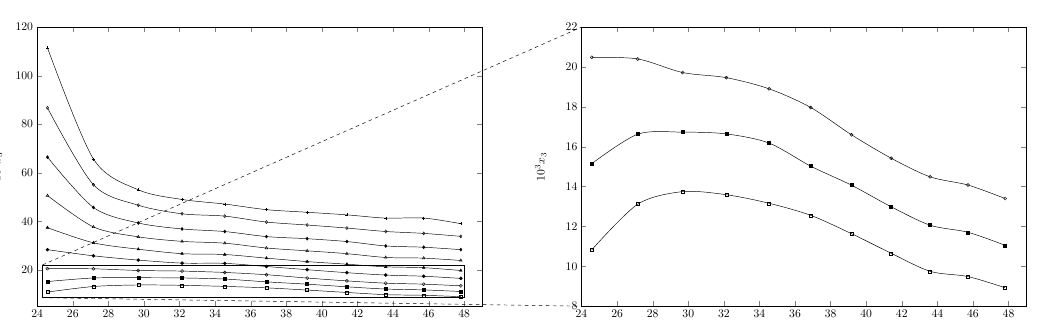
: 288.15 K; : 293.15 K; (cid:78) : 298.15 K; (cid:77) : 303.15 K; (cid:7) : 308.15 K; ◦ •